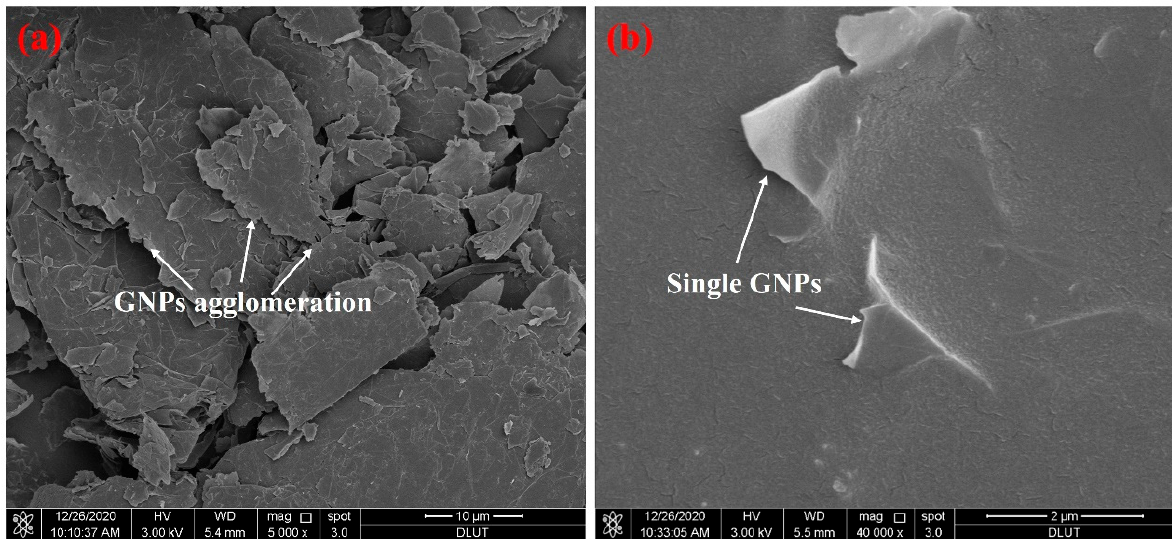
Figure 2. SEM of GNPs; ( a ) before dispersion, ( b ) after dispersion.